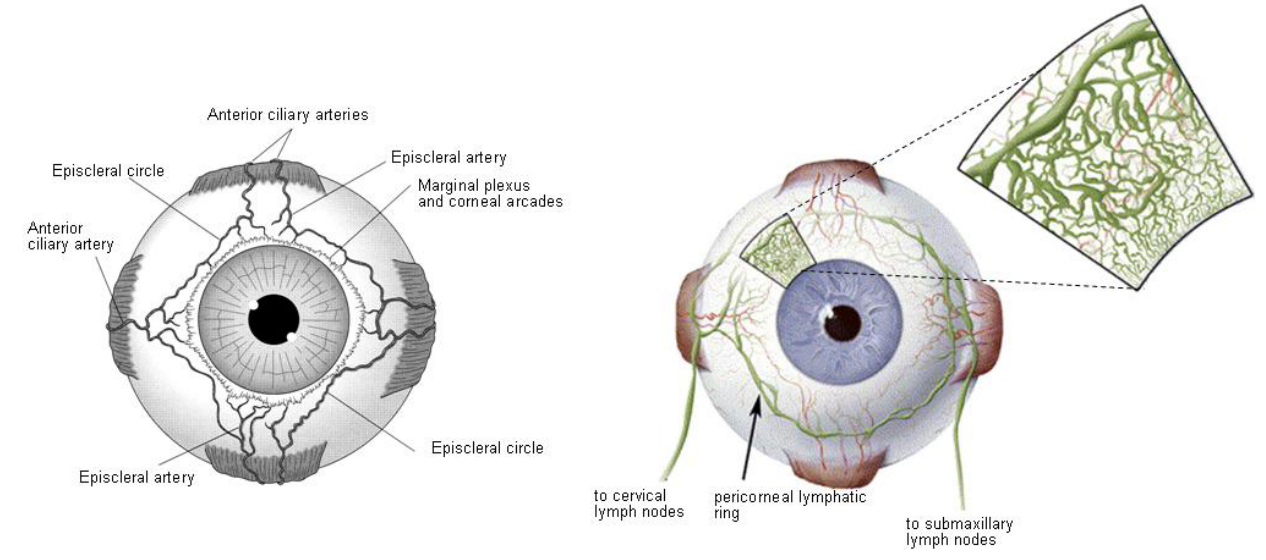
Figure 4. Shematic representations of subconjunctival or episcleral blood vessels, and lymphatics network. (Adapted from Robinson MR, Lee SS, Kim H, et al. A rabbit model for assessing the ocular barriers to the transscleral delivery of triamcinolone acetonide, Exp. Eye Res. 2006 , 82 , 479-487. with permission from Elsevier Inc., and The Human Eye with permission from Sinauer Associates, Inc., copyright